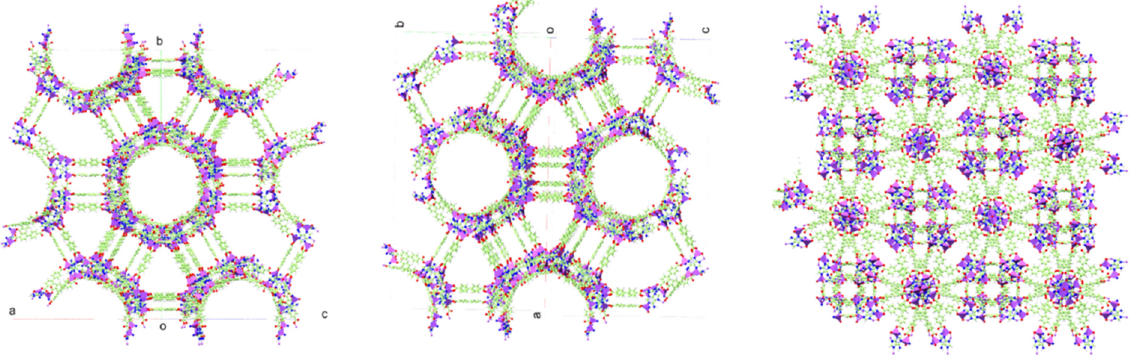
Figure 7. Expanded structure of the coordinating polymer from the conformer 19. View of the wide channels along with the directions [110] (left) and [101] center. The vision of the polymer along the crystallographic c-axis.